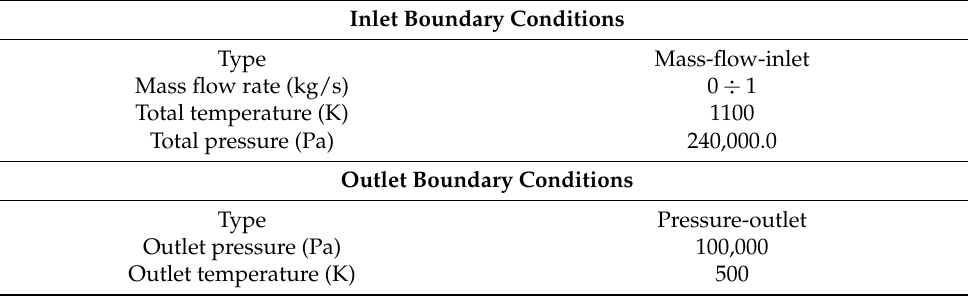
Table 3. The parameters of the boundary